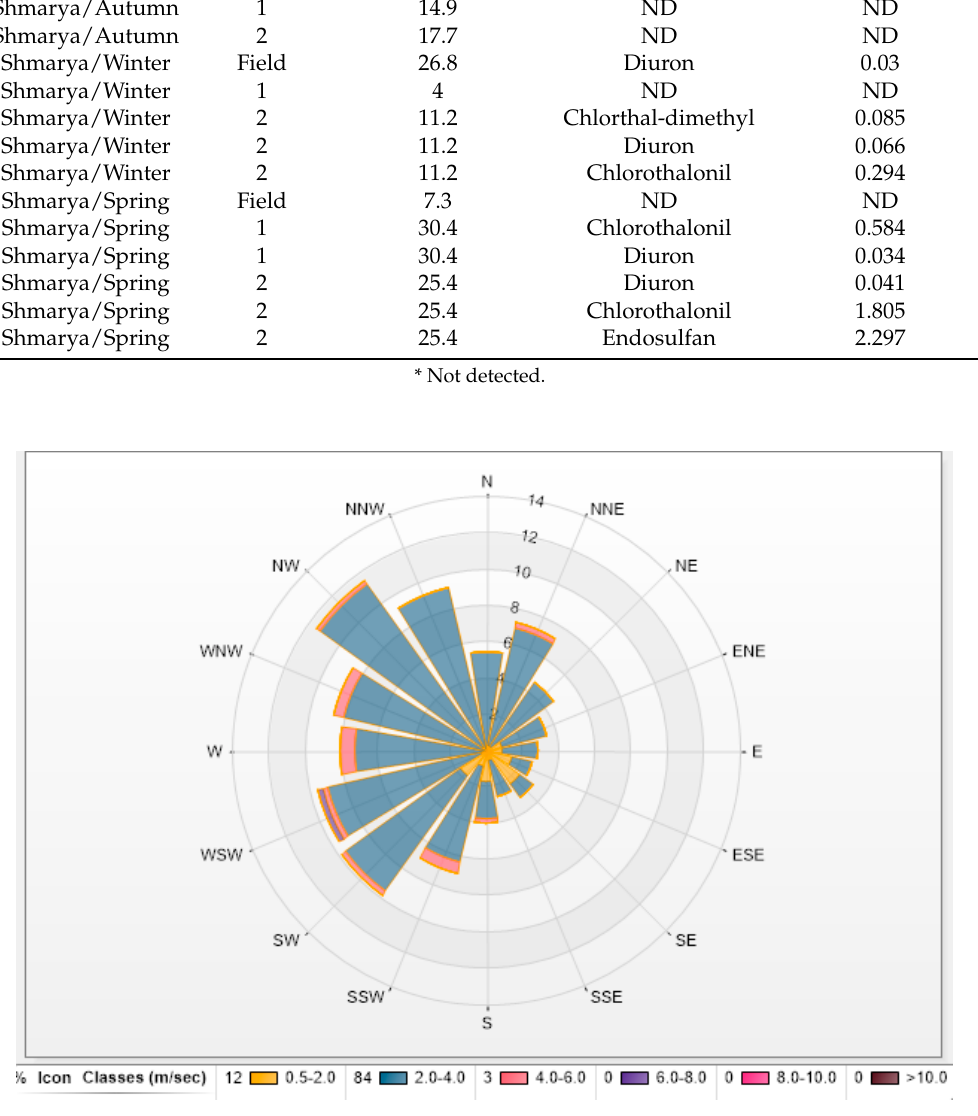
Figure A1. Compass card of the commonness of wind directions for the Northern Negev [34].